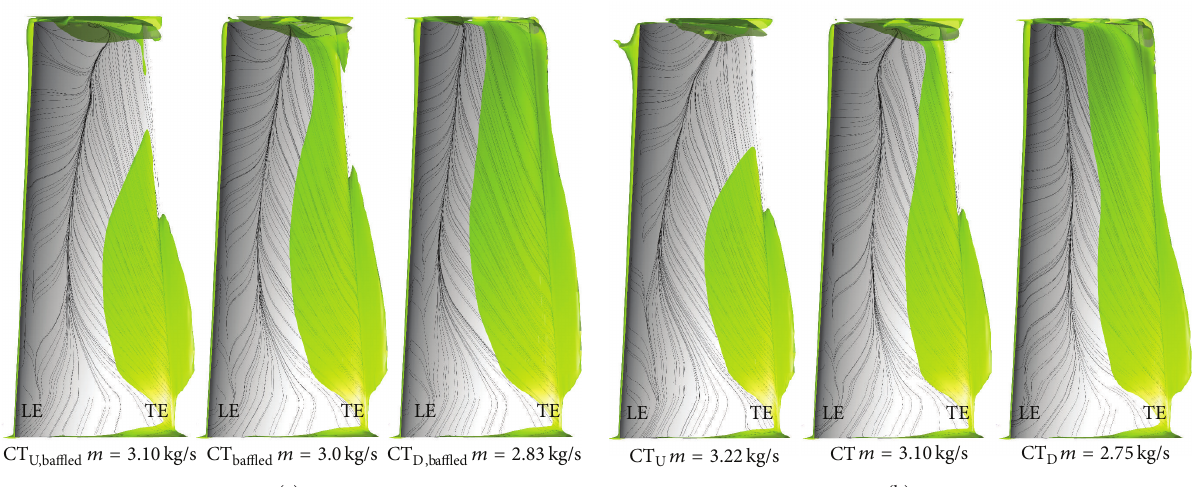
Figure 12: Limiting stream lines and separation on the SS at the NS point of each